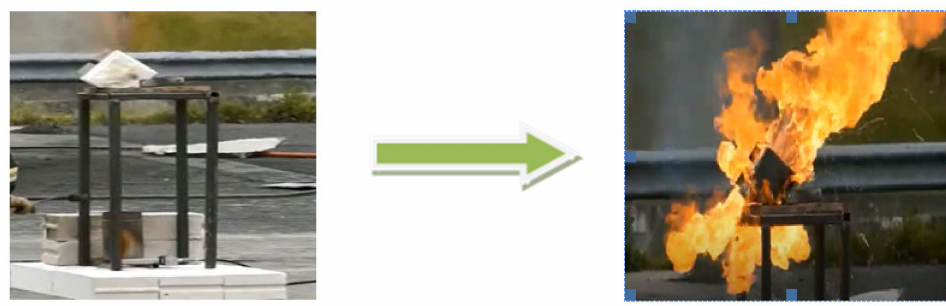
Figure 15. Exp. A.1 experiment. In the Exp. A.2 experiment an NMC-a (Pouch) cell and an LTO (Prismatic) cell were put onto the small burner at the same time. The NMC-a (Pouch) cell showed a faster and more intense combustion compared with the LTO (Prismatic) cell. The NMC-a (Pouch) cell burned intensely and gassed out 7 s after the ignition was started. The LTO (Prismatic) cell did not gas out and burned at the same rate in the same period (Figure 16). The different responses of cells to combustion depends on the structural setup of the batteries.